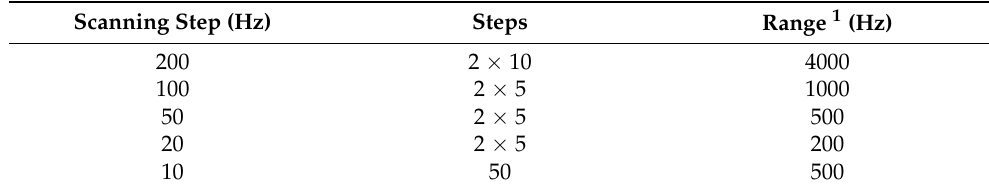
Table 3. The scanned frequency range in case of bioinspired resonant frequency